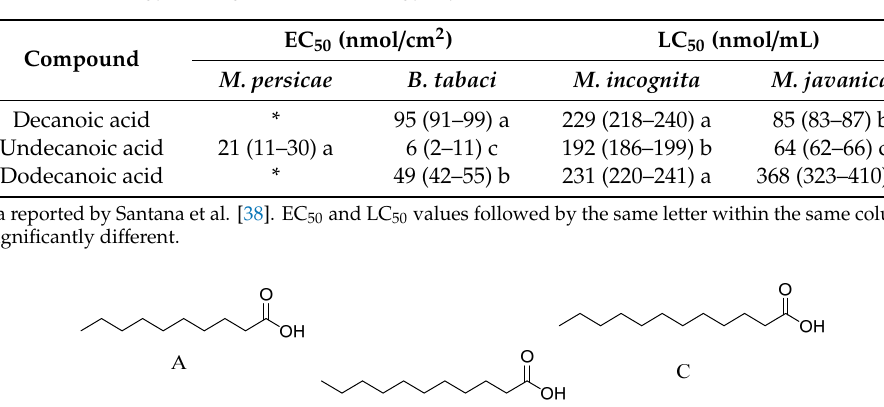
Table 4. Median effective concentrations (EC 50 ) of fatty acids on settling deterrence of two sap-sucking insect species, Myzus persicae and Bemisia tabaci , and median lethal concentration (LC 50 ) of two root-knot nematodes, Meloidogyne incognita and Meloidogyne javanica .